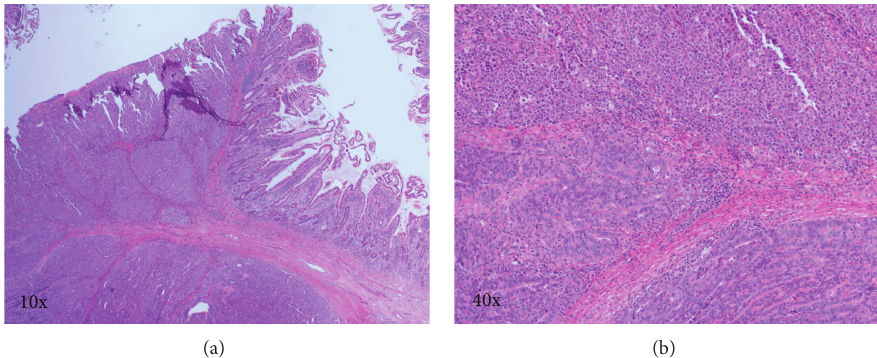
Figure 3: Microscopic images of the tumor from the histopathologic specimen, hematoxylin and eosin stain. (a) Low-power magnification (10x) shows normal small bowel mucosa (right) and invasive adenocarcinoma (left). (b) High-power magnification (40x) shows two patterns of differentiation, with poorly differentiated carcinoma in the upper part of the